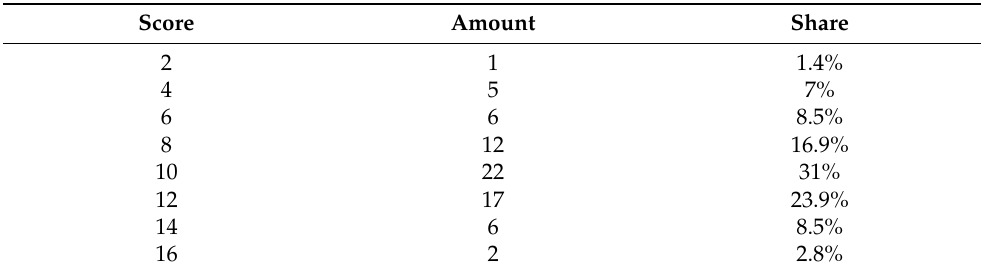
Table 2. Distribution of the SKALE score in our elderly